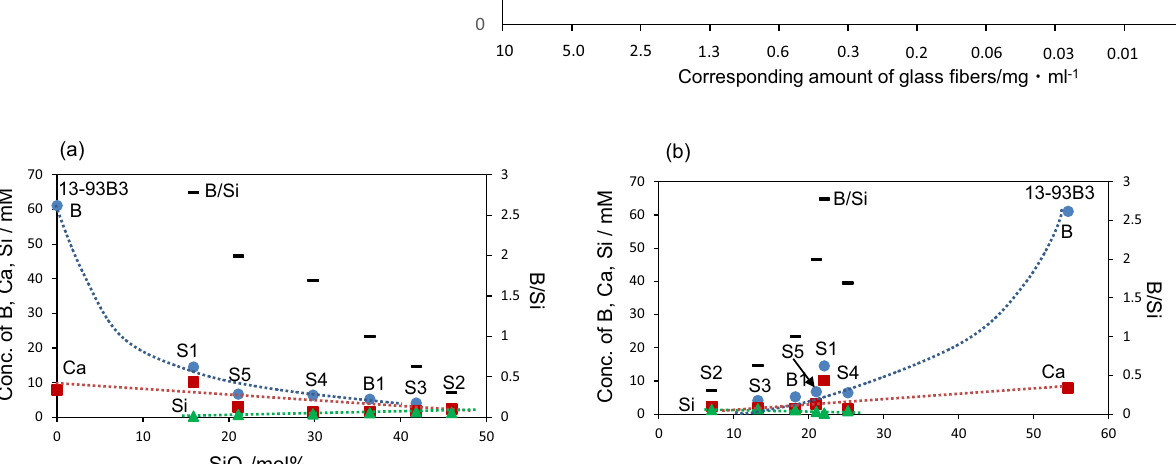
Fig. 10 Concentrations of calcium, borate and silicate ions released from the glasses into SBF for 2 days as a function of ( a ) SiO 2 and ( b ) B 2 O 3 contents of